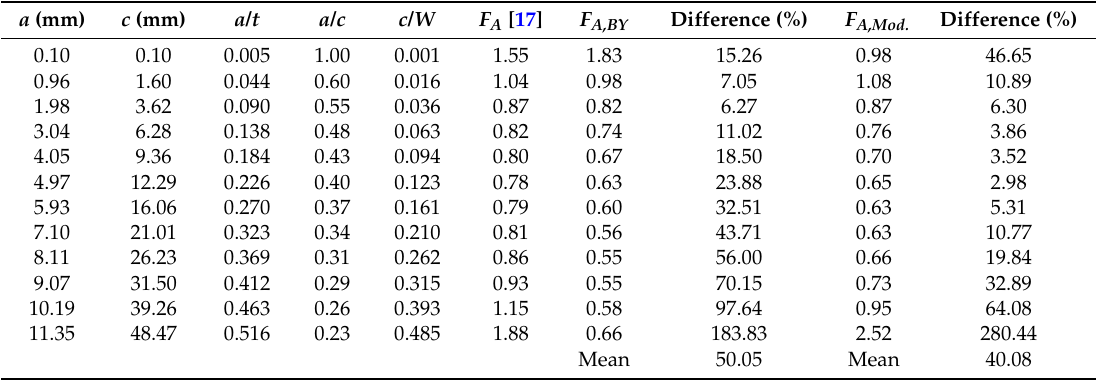
Table 7. Comparison of dimensionless stress intensity factor values from the Baik-Yamada formula, the modified formula and the literature results of the empirical formula at point A .